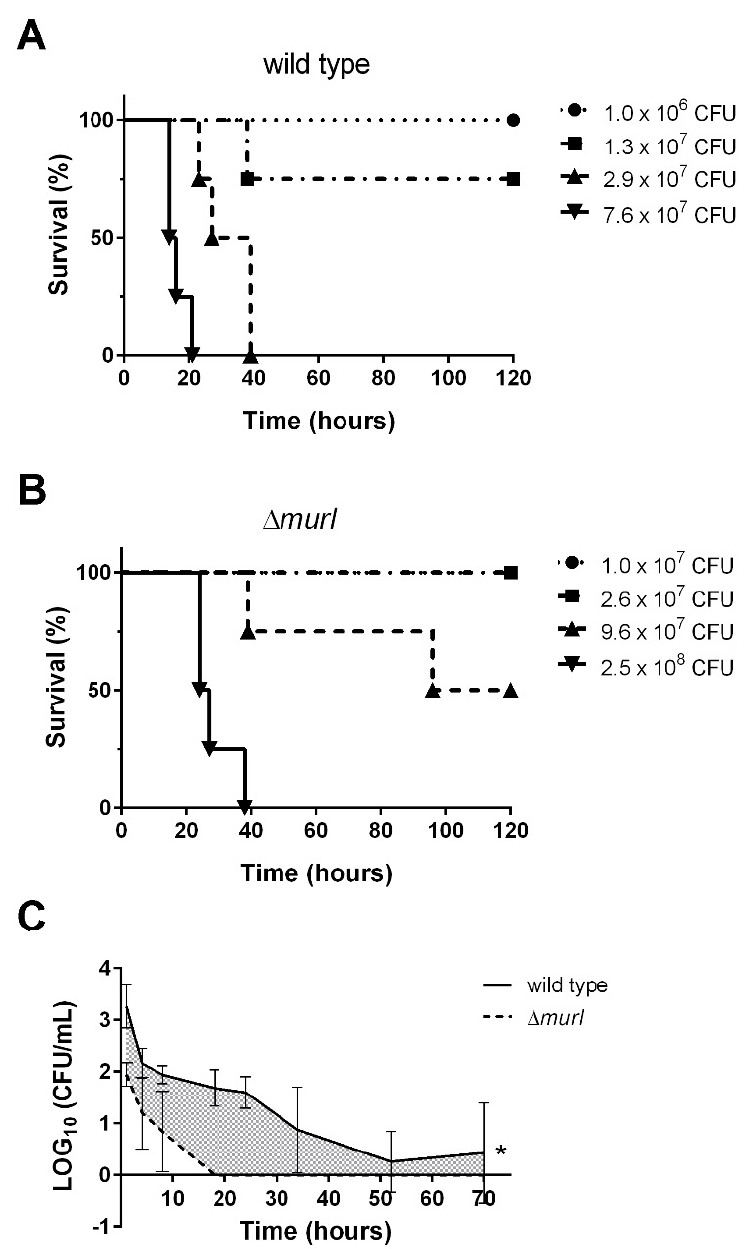
Figure 3. D-glutamate auxotrophic strain of K. pneumoniae MGH 78578 is attenuated for virulence in mice. Survival of BALB/c mice ( n = 4) after i.p. injection with different doses of the MGH 78578 wild-type strain ( A ) and the ∆ murI mutant strain ( B ). Mouse survival was monitored for 7 days. ( C ) Blood clearance of the D-glutamate auxotroph vaccine candidate after intravenous injection. Log 10 CFU per mL of K. pneumoniae recovered from the blood of mice intravenously inoculated with 0.1 mL of the MGH 78578 wild-type (1.2 × 10 7 CFU) and ∆ murI strains (8.9 × 10 6 CFU) over time. * p < 0.05, unpaired t -test.